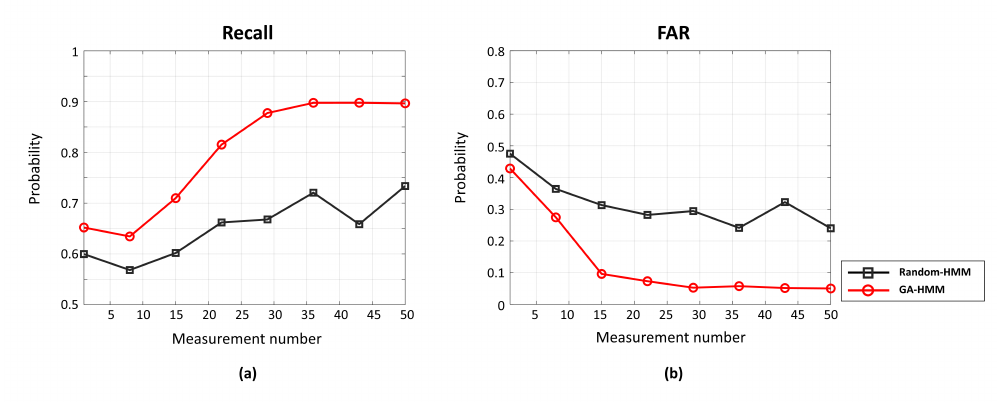
Figure 6. Detection Performance of scheme according to measurement number at fixed SNR of 8 dB: ( a ) Recall; ( b ) FAR.